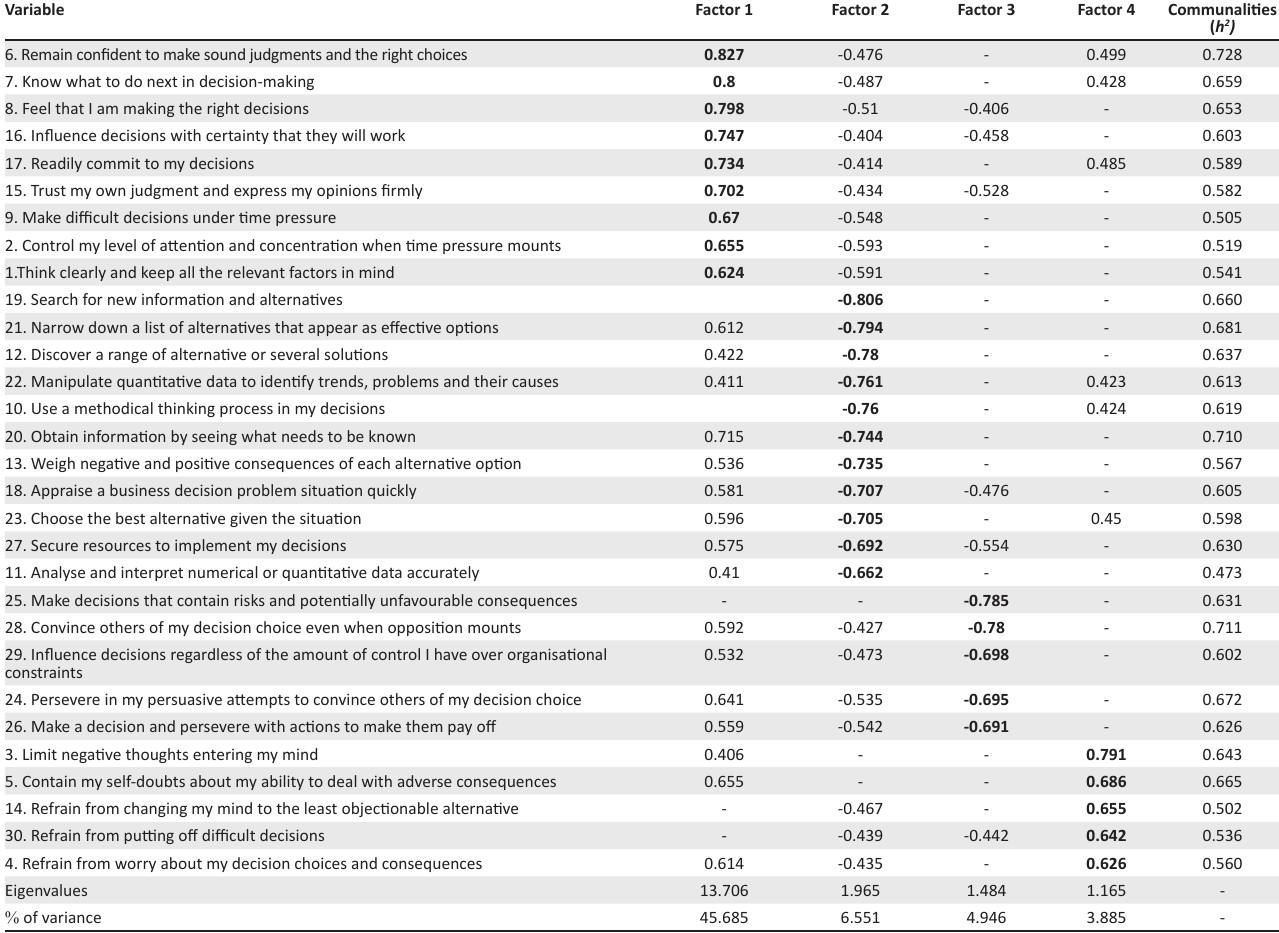
TABLE 2: MDMSEQ: standard regression coefficients obtained via EFA (Oblimin rotation with Kaiser normalisation) ( n = 193).